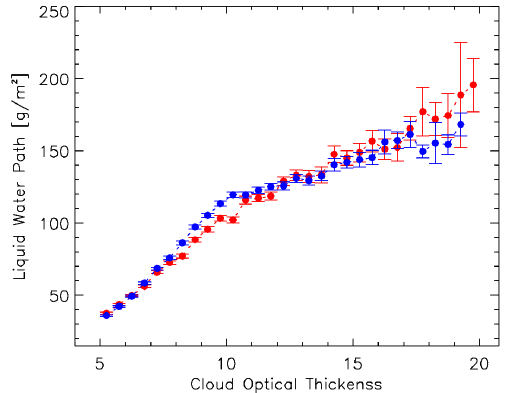
Fig. 12. Liquid Water Path (LWP) retrievals averaged over constant bin of Cloud Optical Thickness (COT). Input data are the same as in Fig.